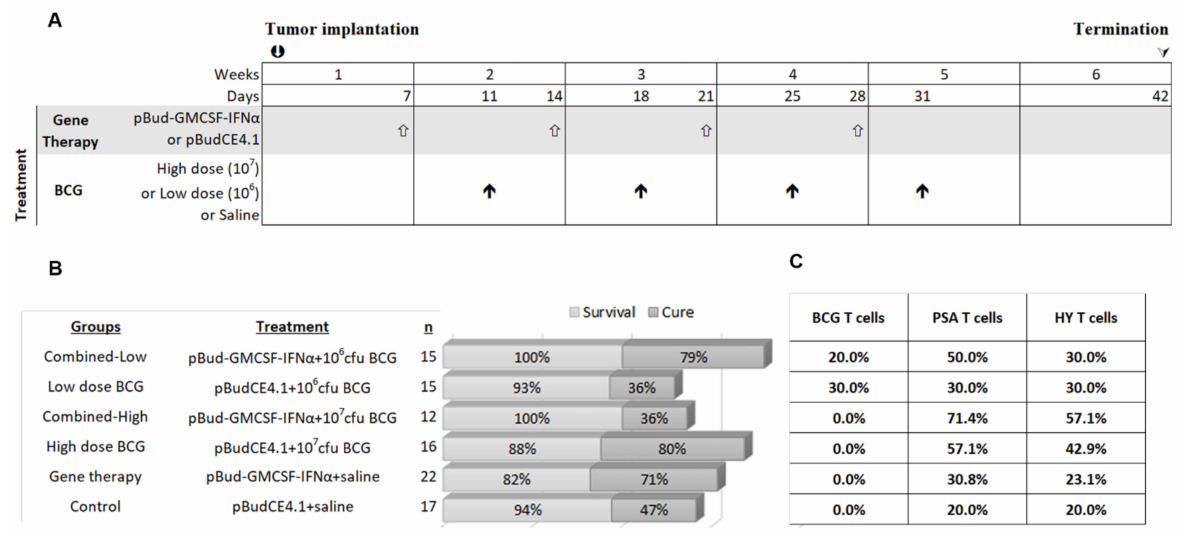
Figure 3. The schedule and outcome of 4 instillations of gene therapy and high and low dose BCG. ( A ) The experimental plan and schedule of instillations are shown as well as experimental groups. ( B ) The outcome of the short-term study, in terms of cure rate and survival, where the cure rate was determined by real-time PCR for the presence of the marker gene PSA. ( C ) The percentage of mice with antigen specific T cells recognizing BCG, PSA and HY in each therapy group are